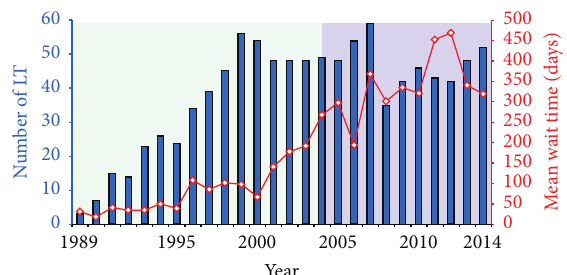
Figure 1: Number of adult cadaveric liver transplants performed per year (bars) and the mean waiting time in days (lines) for liver transplant in Alberta (1989–2014).